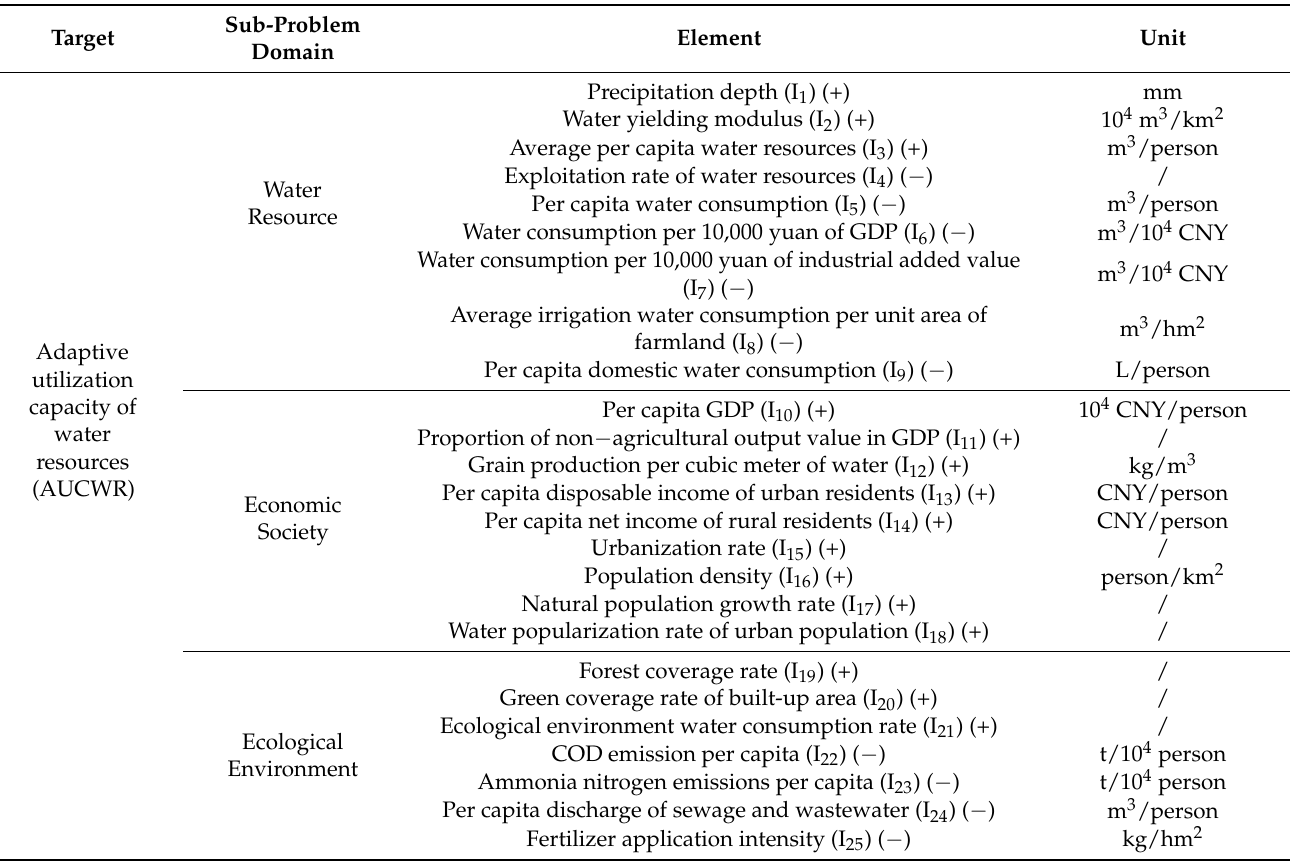
Table 1. Evaluation element system of